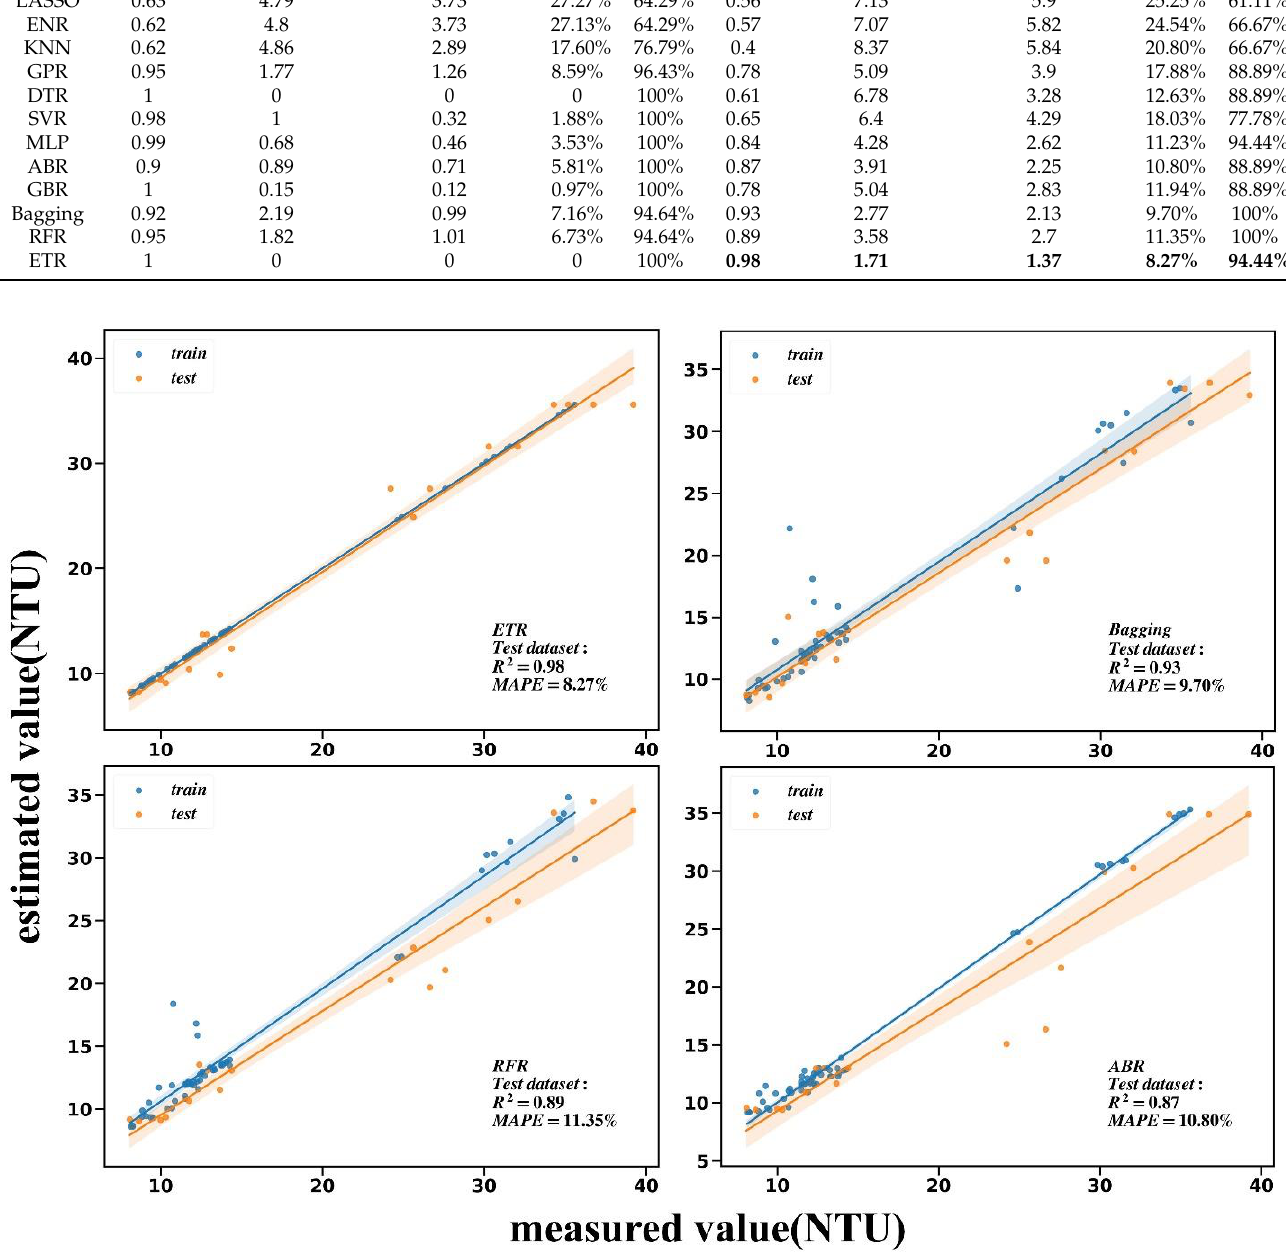
Figure 11. Comparison between the turbidity measured value and the estimated value of the first four models with the highest 𝑅 2 of the test dataset.